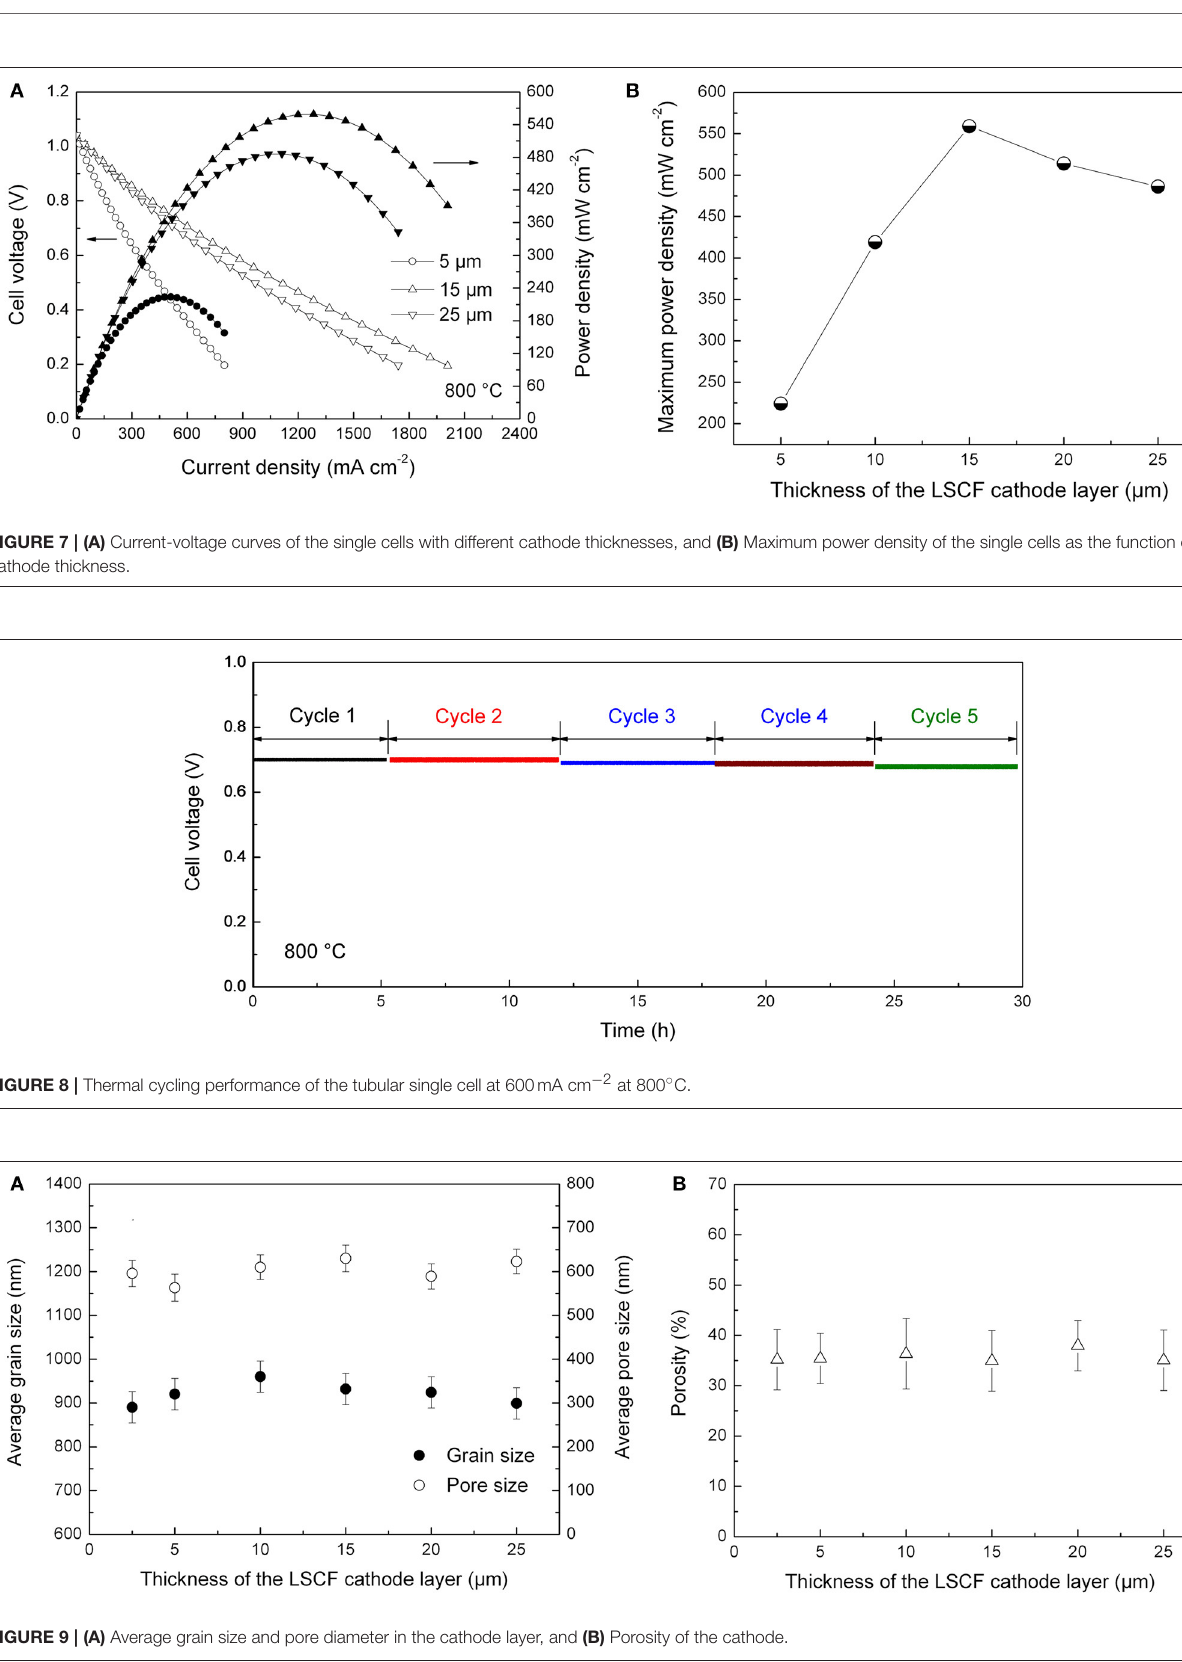
Frontiers in Energy Research | www.frontiersin.org